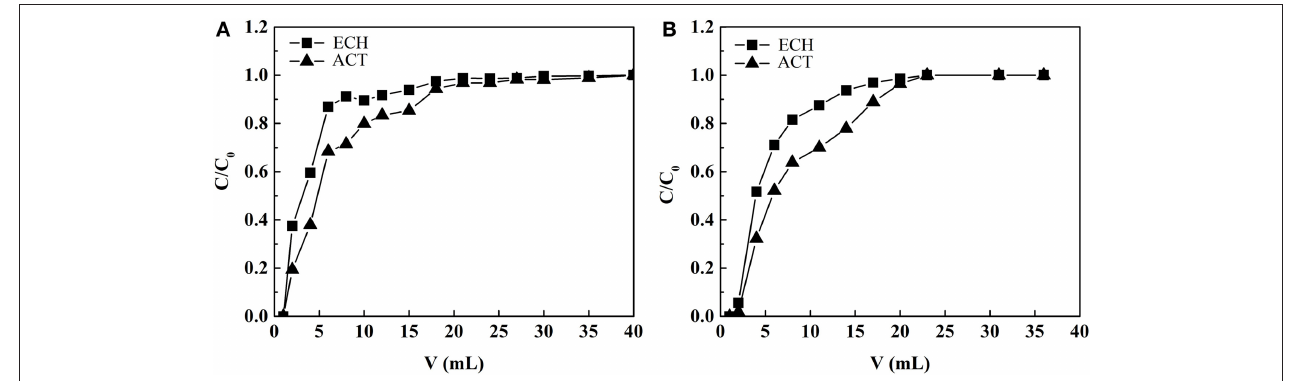
FIGURE 10 | The relationship between effluent volume and effluent concentration in (A) MIP1 and (B) NIP1 adsorption